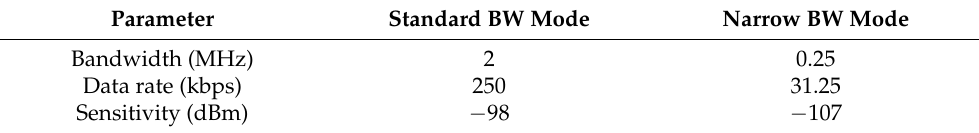
Table 1. IEEE 802.15.4 PHY software-defined radio (SDR) characteristics